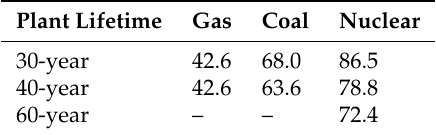
Table 4. Expected Levelized Cost of Electricity (LCOE)